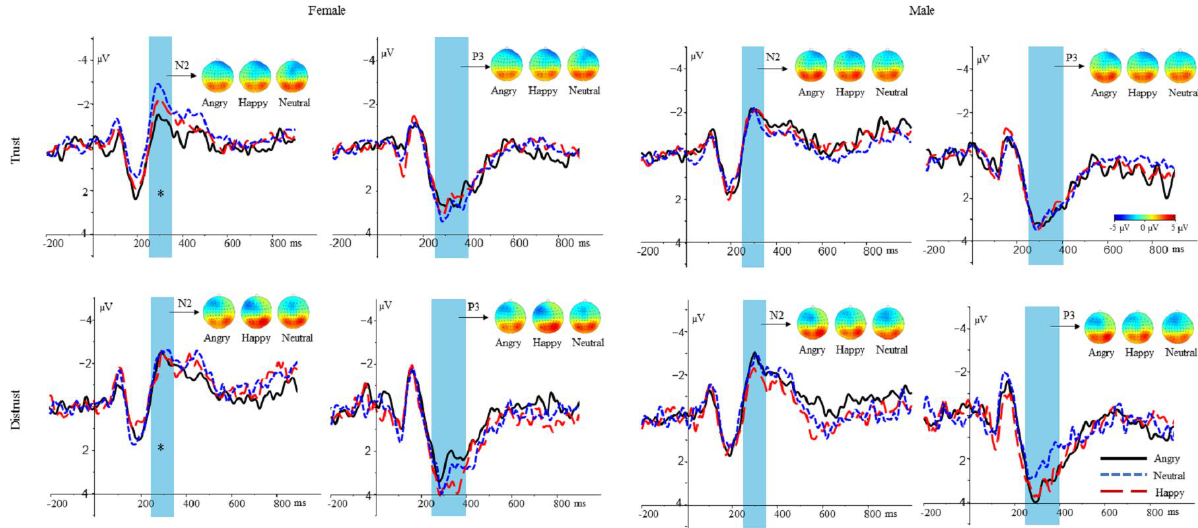
Figure 2. Grand averages according to the making-choices stages. The first row contains grand averages (N2 on electrode Fz and P3 on electrode Pz) for trusting decision, separated by happy, angry, and neutral faces of female or male trustees. The second row contains grand averages (N2 on electrode Fz and P3 on electrode Pz) for distrusting decision, separated by happy, angry, and neutral faces of female or male trustees. Vertical lines indicate the time windows that were quantified for statistical analyses. The topographic maps are also based on these time windows. *: p < 0.05.